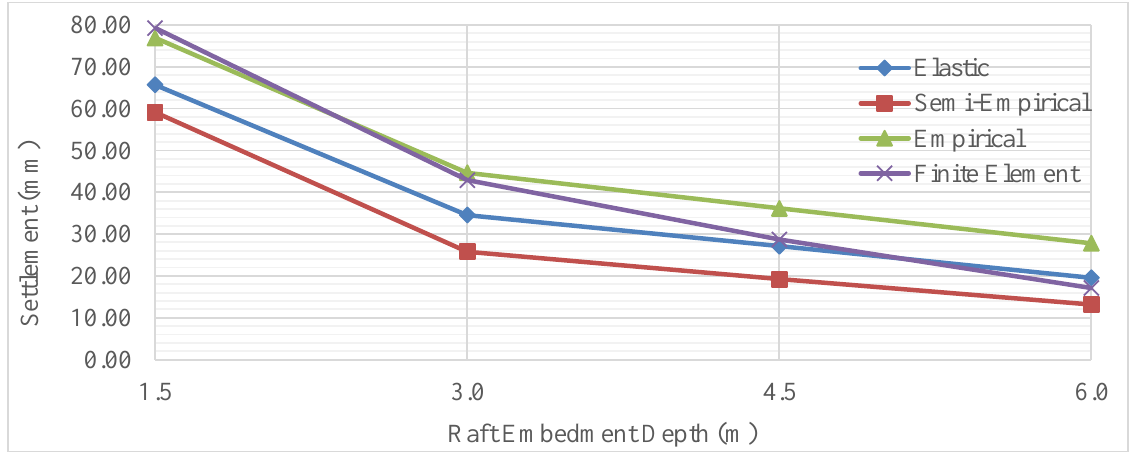
Fig. 7. Settlement versus embedment depth for 300 kN/m 2 applied pressure.